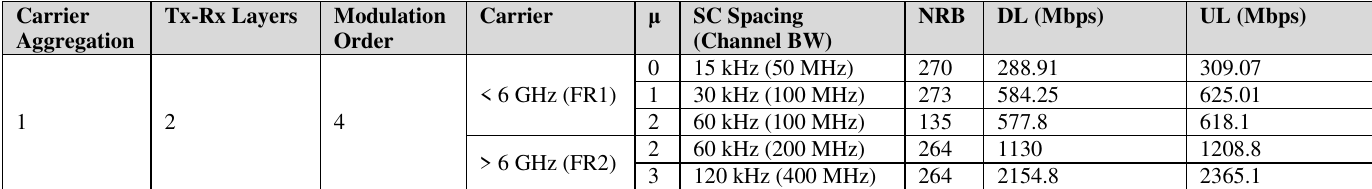
TABLE IV: DATA RATES FOR CORRESPONDING